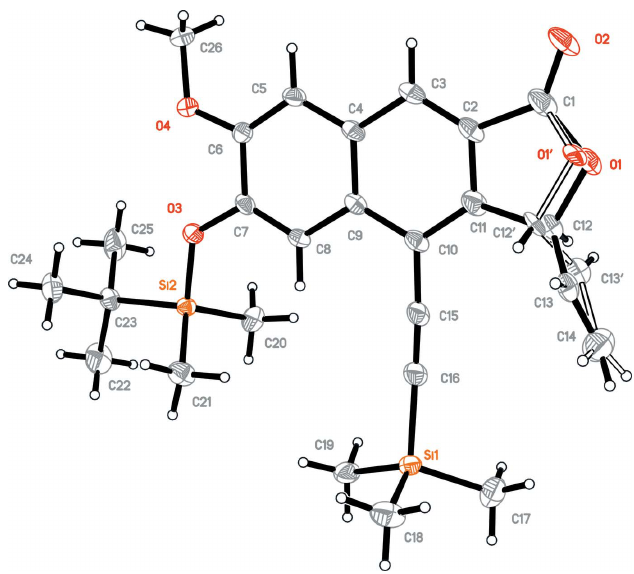
Figure 2 The molecular structure of the title compound, showing anisotropic displacement ellipsoids at the 50% probability level. The disordered part with a minor contribution is shown with open